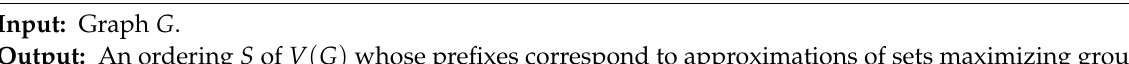
Algorithm 1 An outline of the greedy algorithm for group degree centrality.